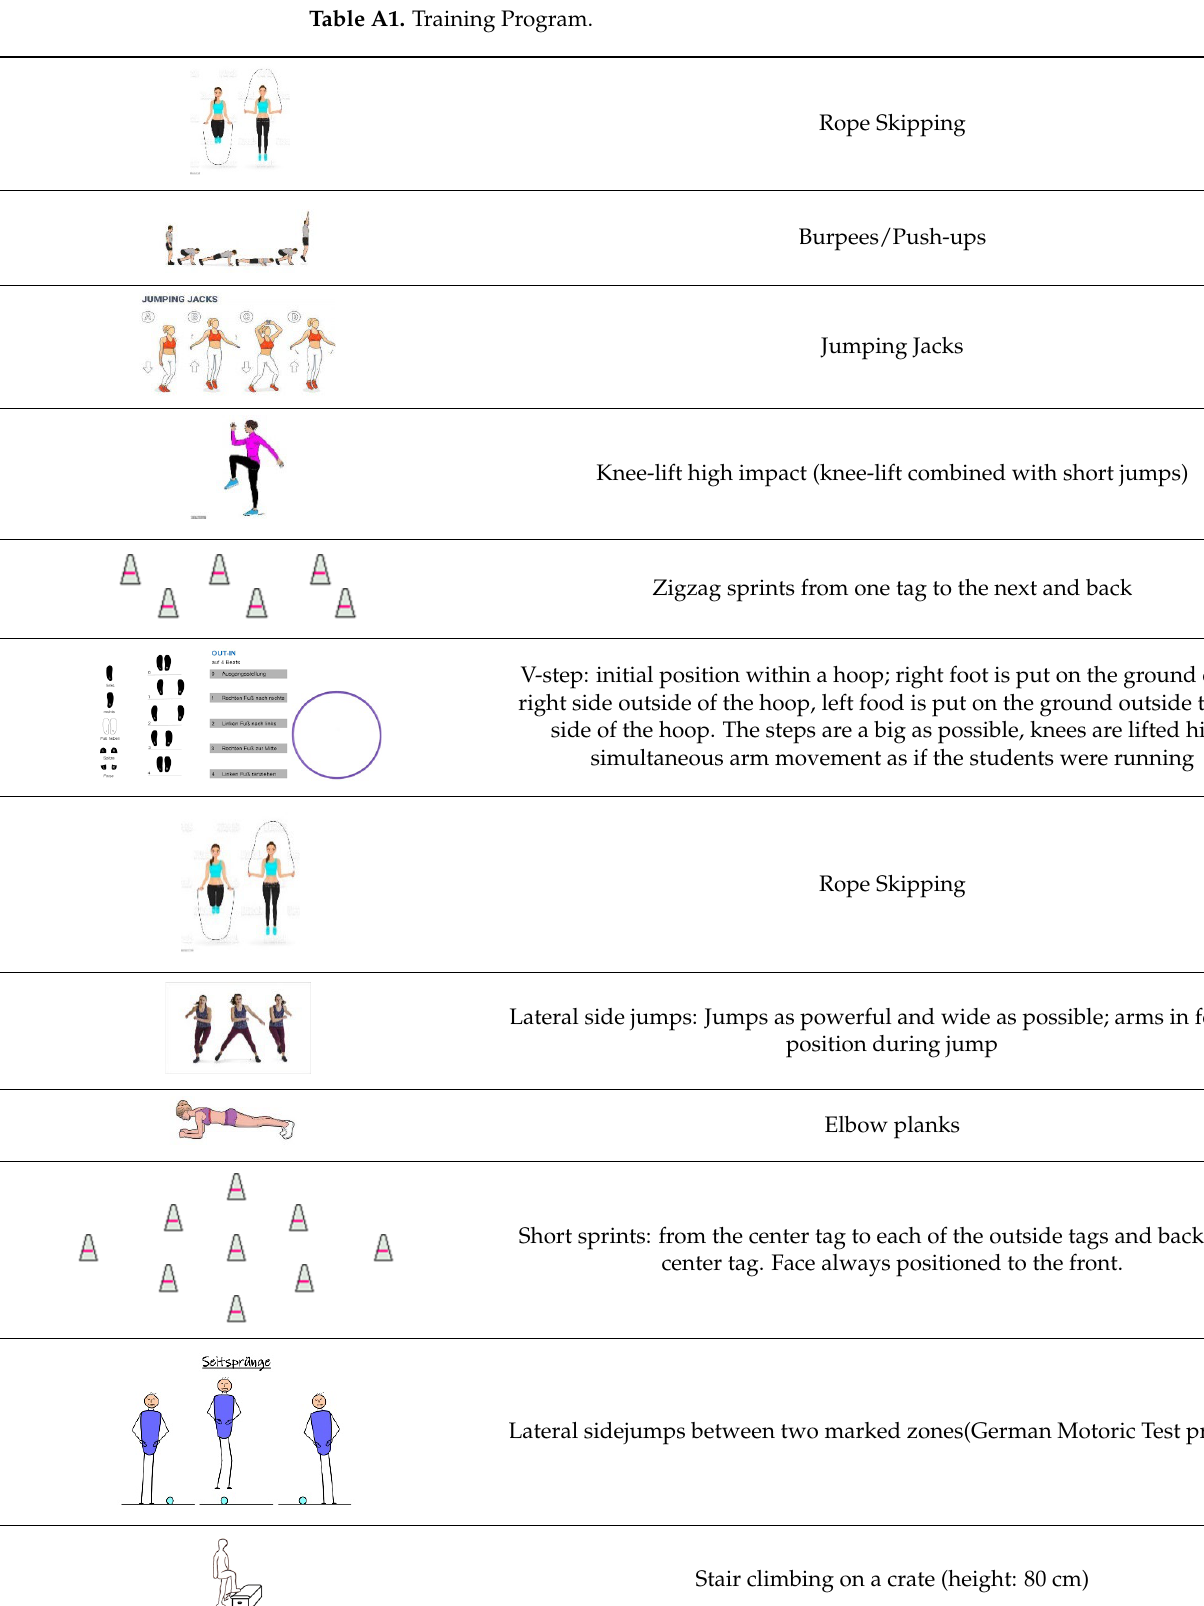
Stair climbing on a crate (height: 80 cm)